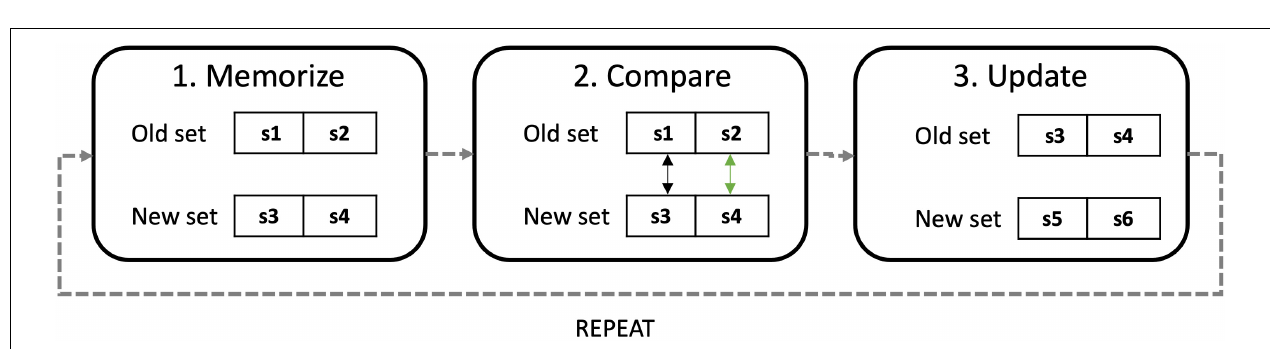
FIGURE 5 | Diagram explain strategy instructions: participants were instructed to create a memory array with the first “n” items in the stream, then to create a second array with the next “n” items. At this point they could compare “new” items with “old” ones and respond. Finally, they had to discard the “old” array, not necessary, and create a new one. The process was repeated until the end of the stream.